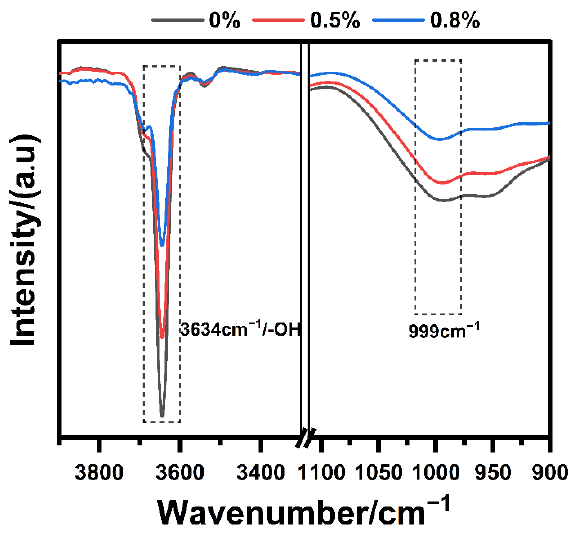
Figure 13. FT-IR spectra of NHL samples with different IBMA content after 7 days of curing.